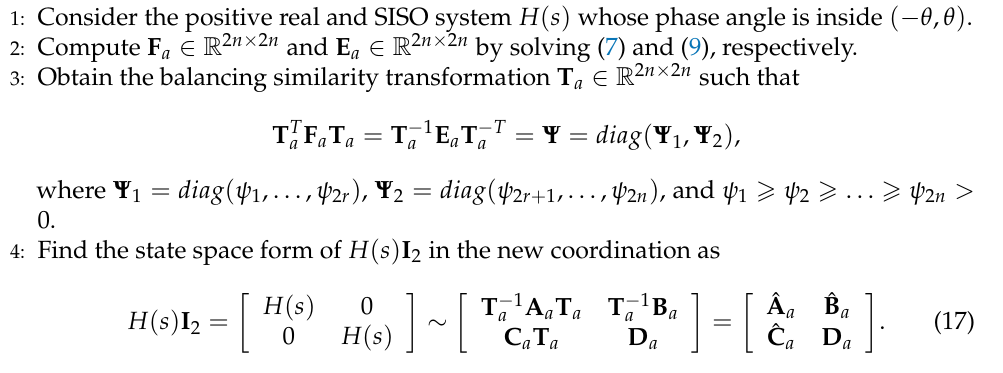
Algorithm 1 Phase preserving balanced